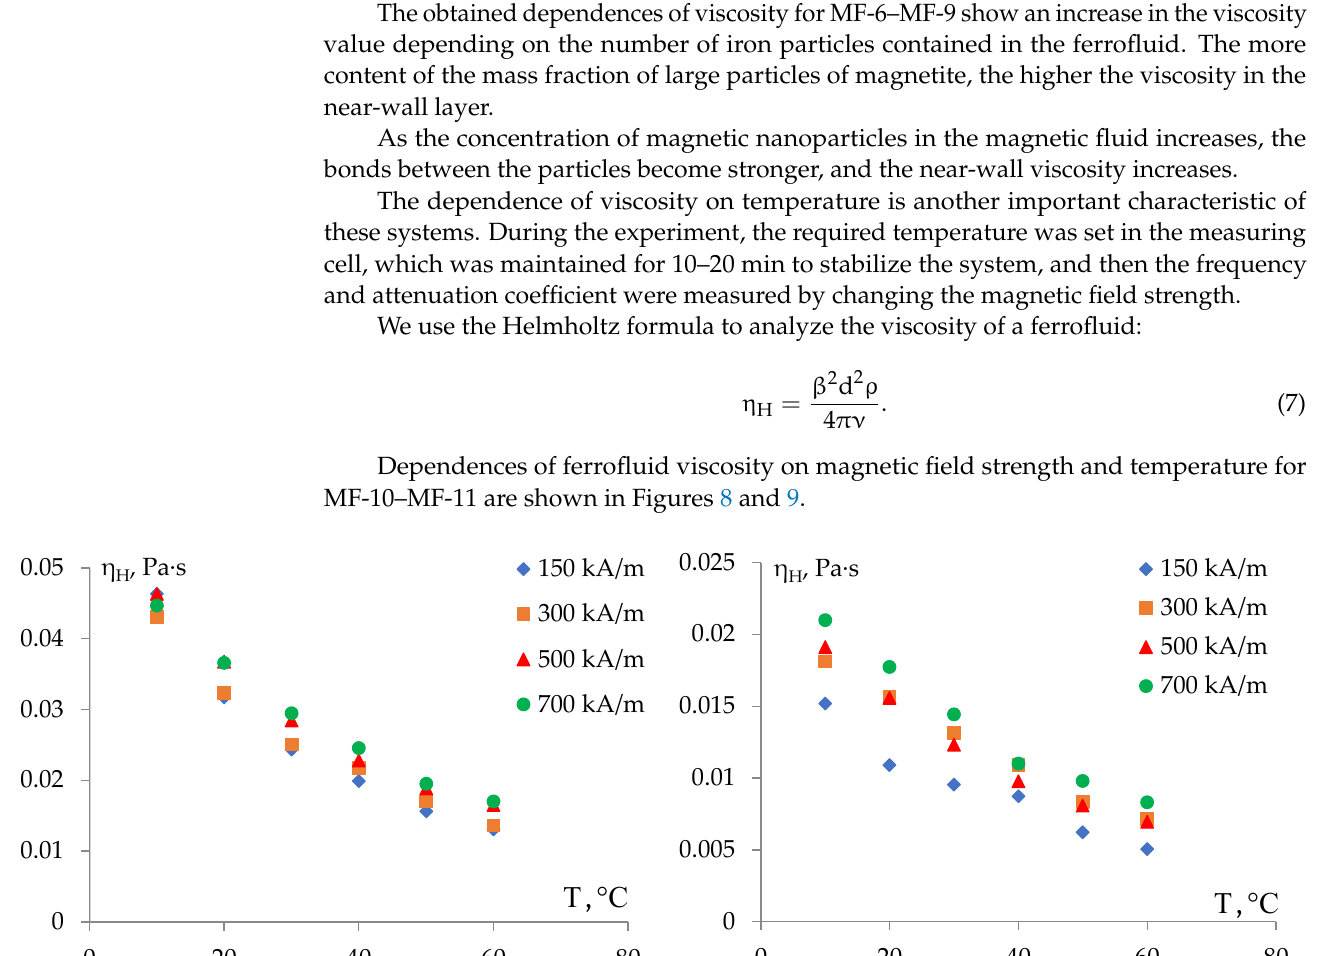
Figure 7. Dependence of viscosity on magnetic field strength for samples MF-6 – MF-9.